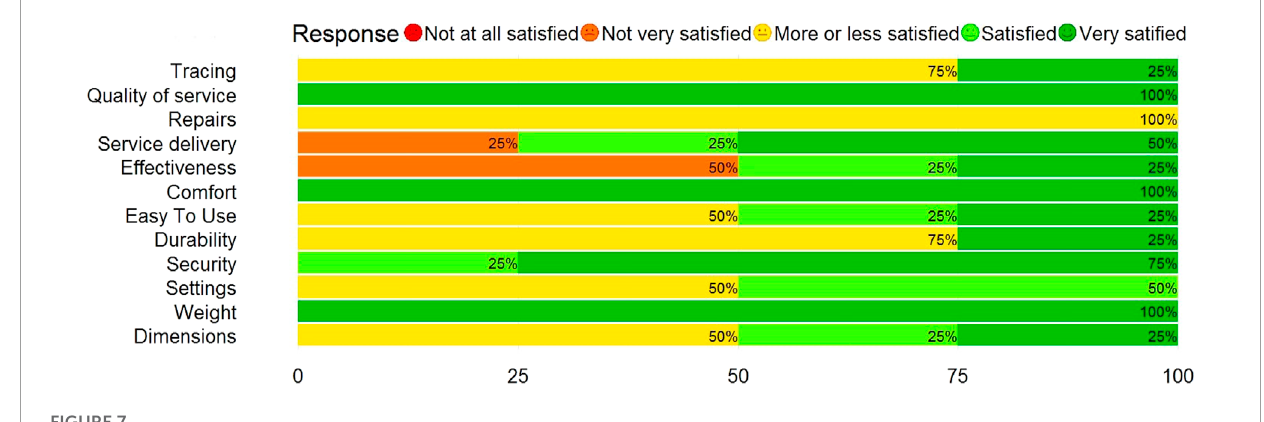
FIGURE 7 Results of the QUEST questionnaire.